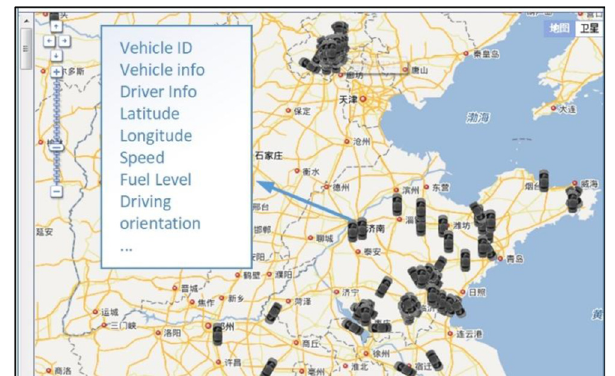
Figure 1 Vehicular network big data